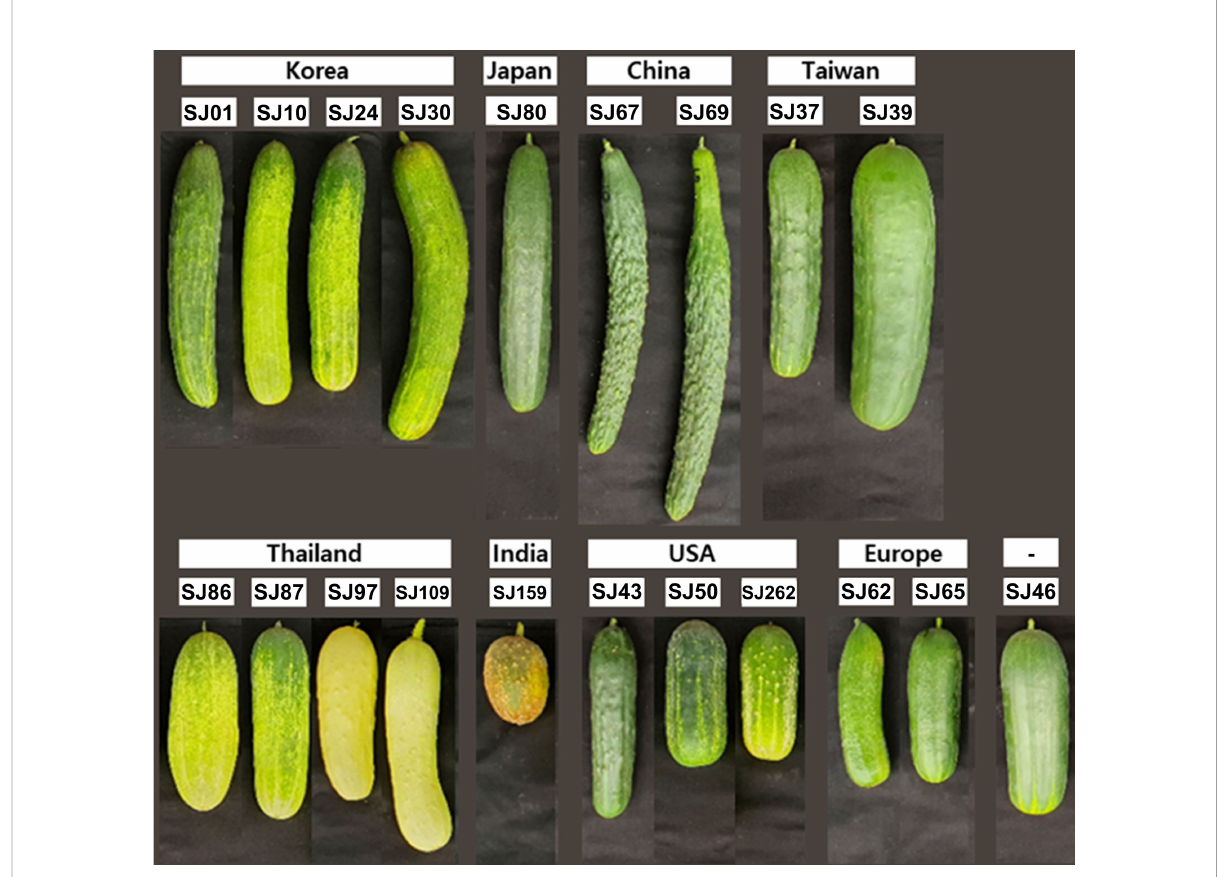
FIGURE 1 Immature fruits of the representative 20 cucumber breeding lines evaluated in this